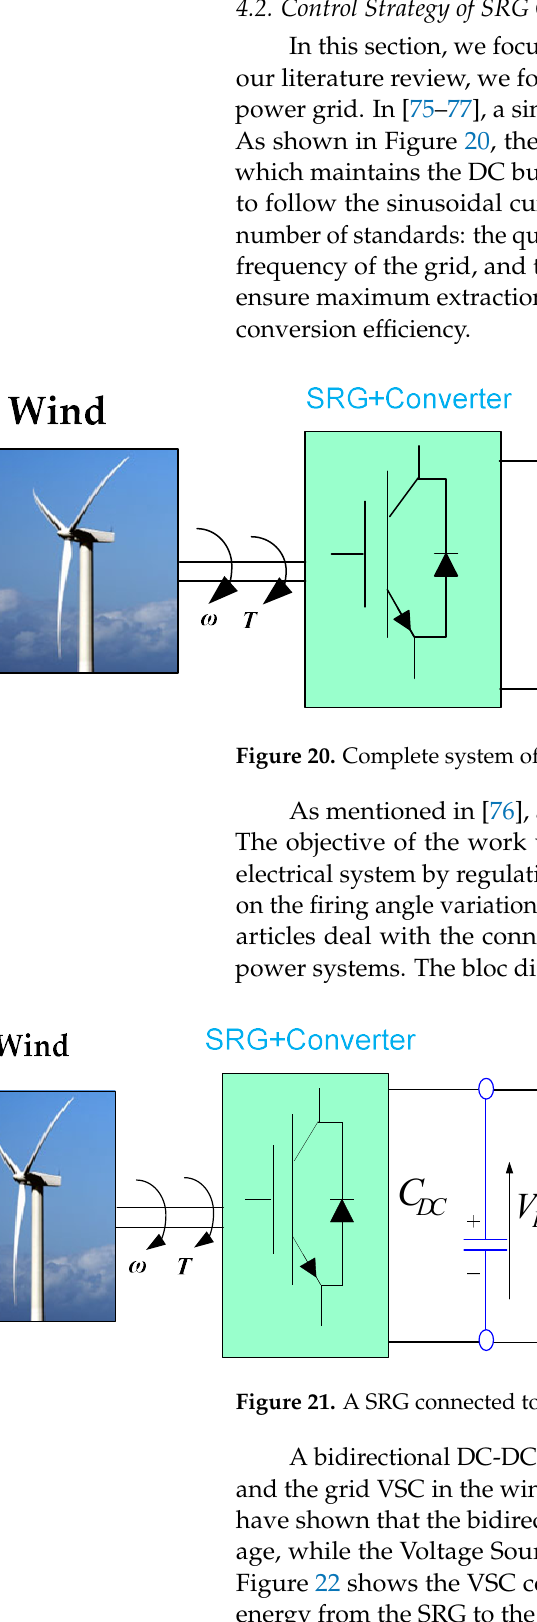
rq V Figure 22. The bloc diagram of voltage source converter (VSC) control. The phase-locked loop (PLL) techniques have been used to ensure the synchronization between grid-interfaced converters and the utility network [83]. In [84], a speed-control system based on adaptive neural network current control has presented. The SRG has been connected to a power grid through the VSC control. To enhance the quality of SRG power, in-loop filtering approaches are presented in [85]. These methods are based on the elimination of voltage ripples in the DC link voltage due to the SRG switching operation. In [86], the authors address a DC micro-grid, they use an DC-DC interleaved converter to raise the output of the SRG voltage from 48 V to 400 V.